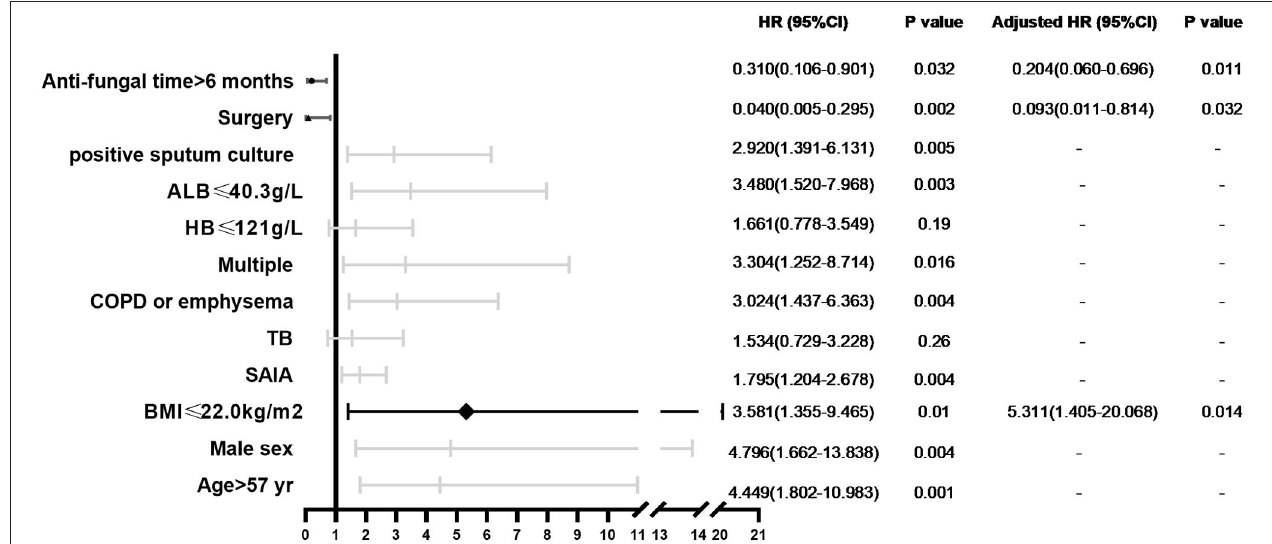
FIGURE 2 | Forest plot of prognostic factors independently associated with 10-year mortality in patients with CCPA and